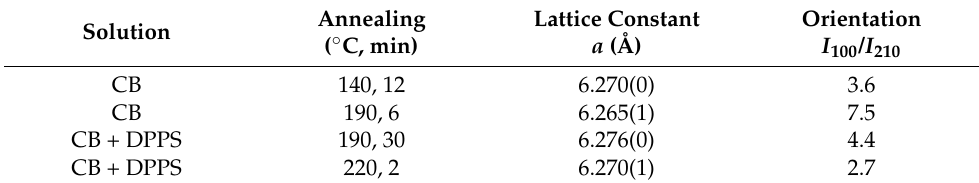
Figure 5. ( a ) X-ray diffraction patterns of the devices. ( b ) Enlarged patterns of 100 reflections. Table 2. Crystallographic data of perovskite films.